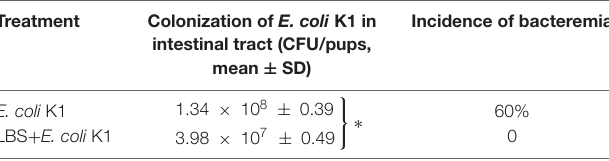
TABLE 1 | The population of Escherichia coli K1 colonization and incidence of bacteremia. Treatment Colonization of E. coli K1 in Incidence of intestinal tract (CFU/pups,